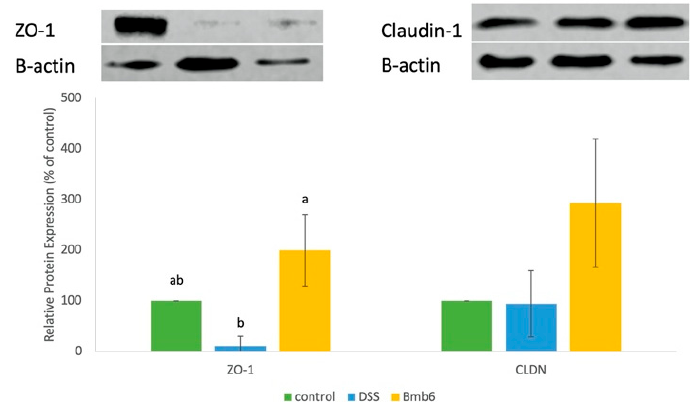
Figure 7. Western blot analysis of the expression ZO-1 and claudin-1 in DSS-induced colitis mice. Data represent the mean ± standard deviation ( n = 6 mice per group). Tukey’s multiple comparison test was performed, and different lowercase letters indicate statistically significant differences ( p < 0.05).